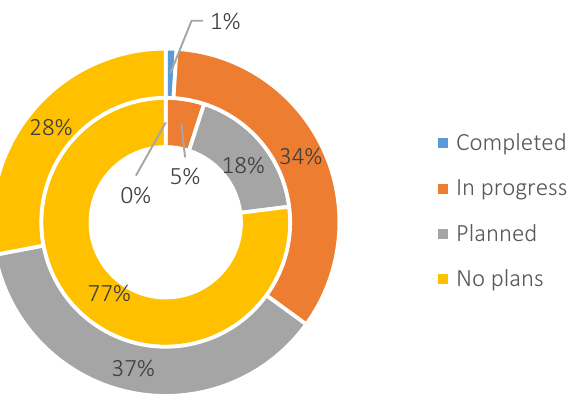
Figure 5. The activity of banks related to the establishment of a green transition plan with climate goals